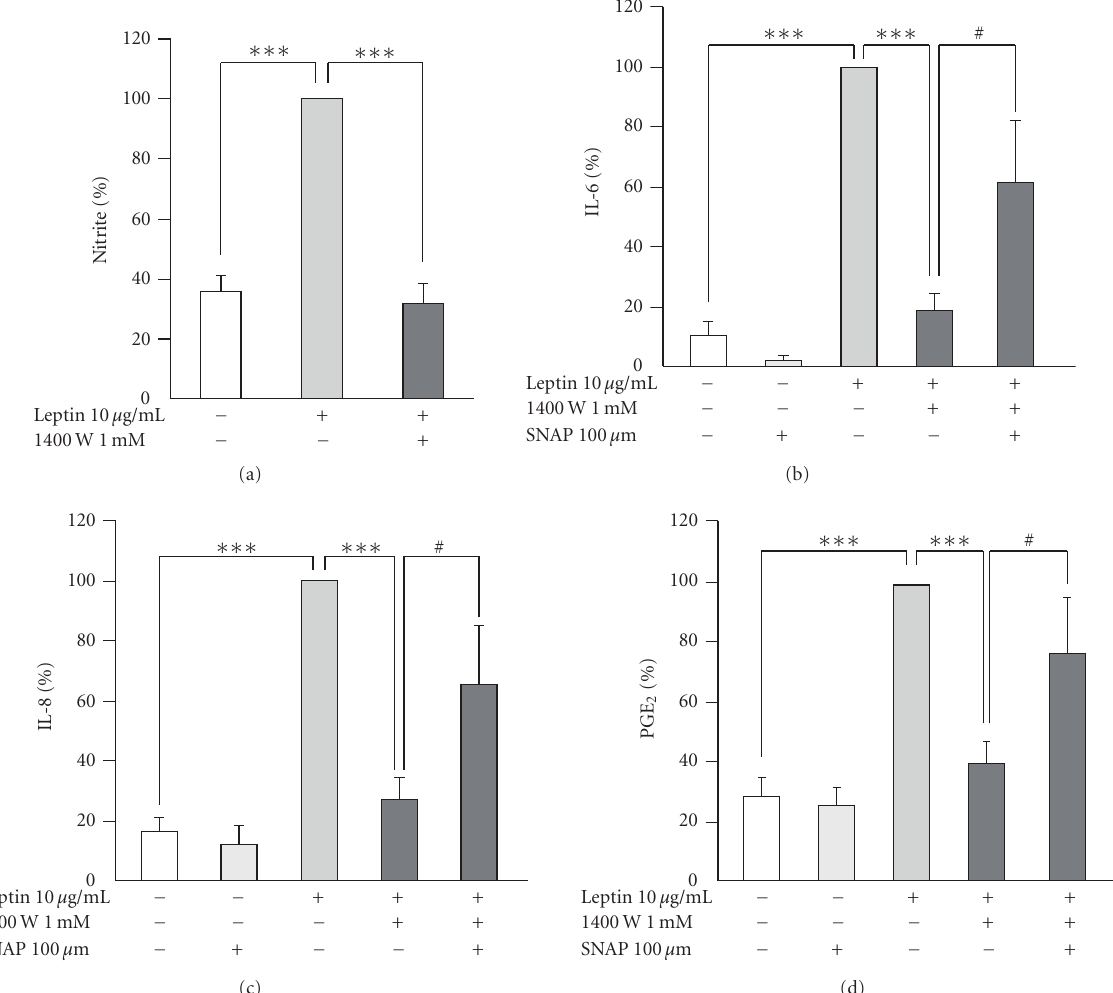
Figure 4: The e ff ects of a selective iNOS inhibitor 1400 W (1mM) ((a)–(d)) with and without NO-donor SNAP ((b)–(d)) on leptin (10 μ g/mL) induced NO (a), IL-6 (b), IL-8 (c), and PGE 2 (d) production in OA cartilage during 48 hours incubation. In the culture medium, NO production (a) was measured as nitrite accumulation by Griess reaction, levels of IL-6 (b) and IL-8 (c) were measured by ELISA, and PGE 2 production (d) was measured by RIA. Leptin-induced NO/PGE 2 /IL-6/IL-8 production was set as 100%, and the other values were related to that. The results are expressed as mean ± SEM. Samples were collected from 8 patients in (a) ( n = 8), from 6 patients in (b) ( n = 6), from 8 patients in (c) ( n = 8), and from 6 patients in (d) ( n = 6). #: P < . 2, ∗ ∗ ∗ : P < . 001.